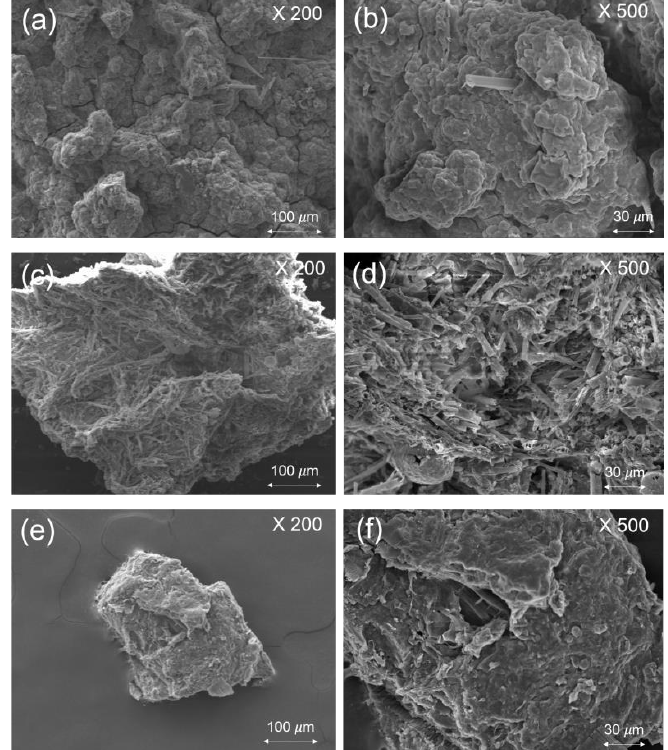
Figure 2. SEM images of harvested and dried MB samples collected directly from the three water treatment facilities. ( a , b ) AHS; ( c , d ) DAF; ( e , f )